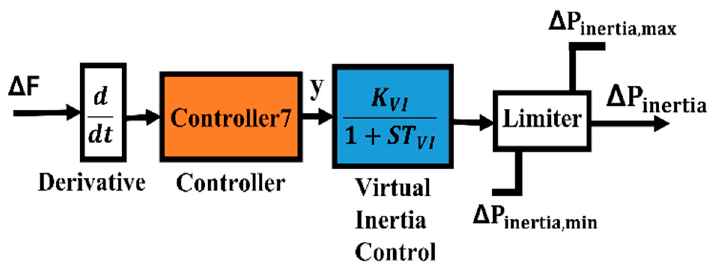
Figure 10. Typical structure of a virtual inertia control block.